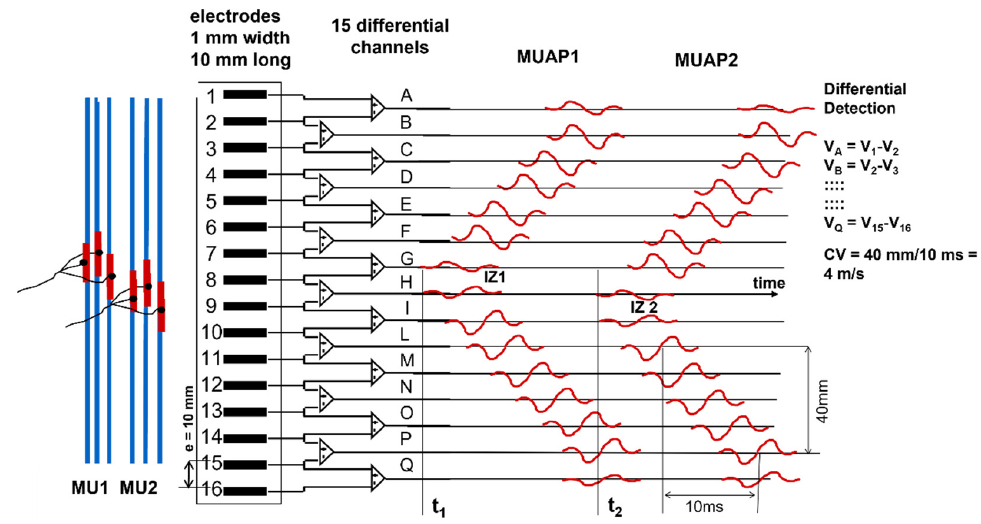
Figure 7. Schematic drawing of the propagation of two motor unit action potentials (MUAPs) under a linear electrode array that is aligned with the fiber direction. MU1 discharges at time t 1 and MU2 discharges at time t 2 : example of the estimation of the innervation zones and the calculation of the muscle fiber conduction velocity (CV). (See animation in Supplementary Materials, Sup4). Reproduced from (https://www.robertomerletti.it/en/emg/material/teaching/module6). Note that signals from double (or multiple) IED values may be obtained either by taking the difference between the corresponding monopolar signals or by adding adjacent